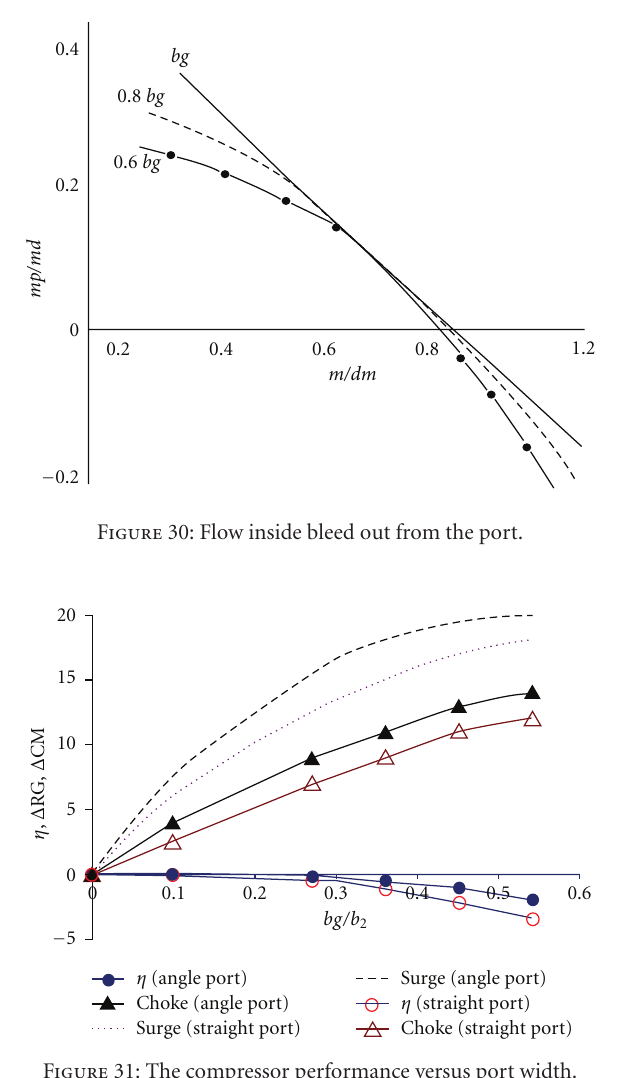
Figure 31: The compressor performance versus port width.